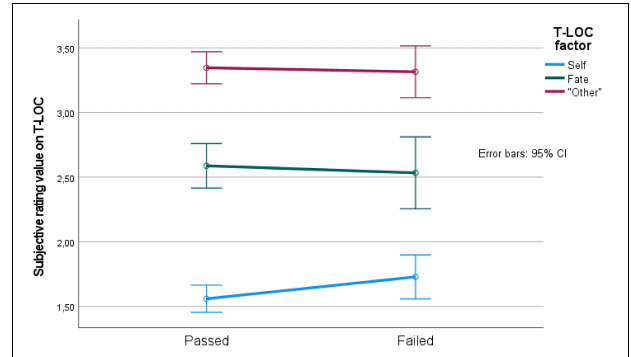
FIGURE 4 | T-LoC factor values for passed vs. failed driving simulator test participants. CI, confidence interval.